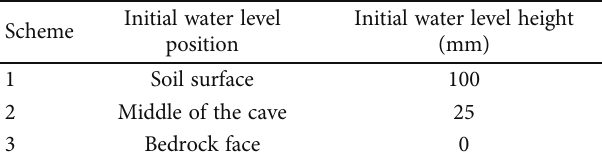
Table 2: Model test scheme.